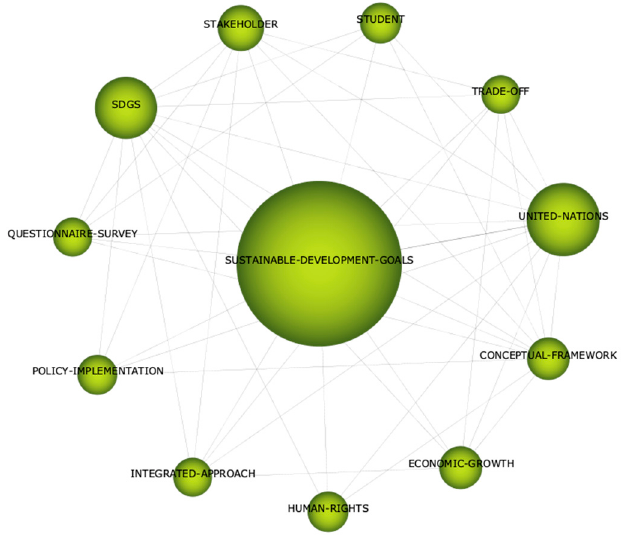
Figure 6. Thematic networks by period